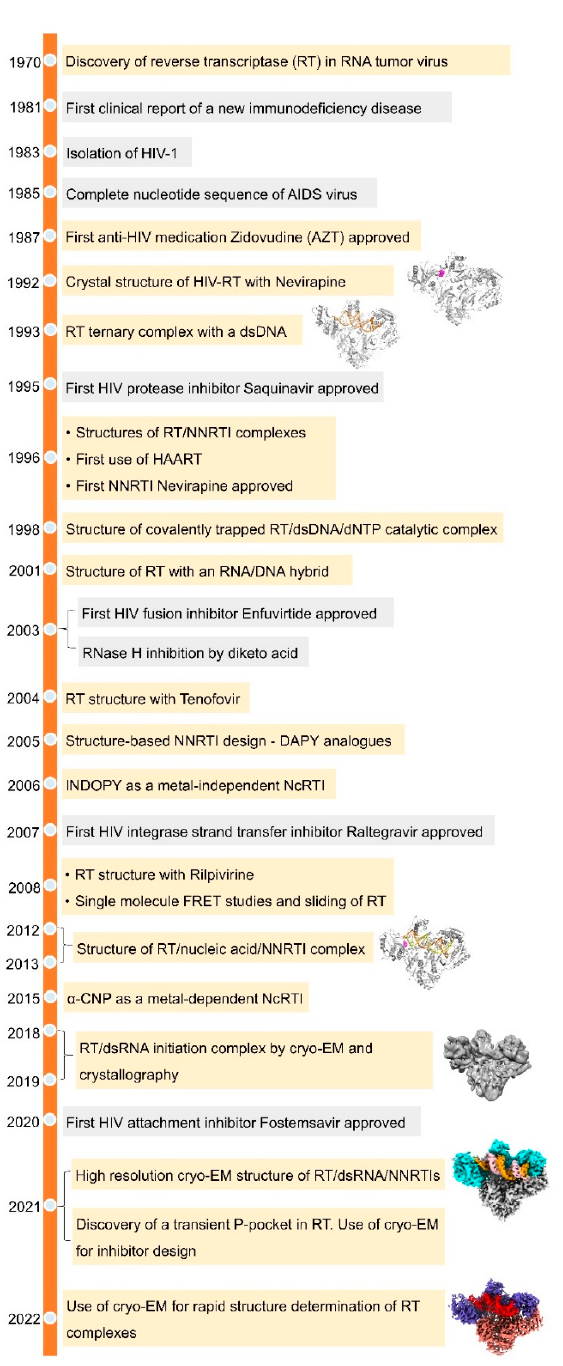
Figure 1. A historical perspective of key developments in HIV-1 research. Events concerned with HIV-1 RT and its structural biology are highlighted in cream color.